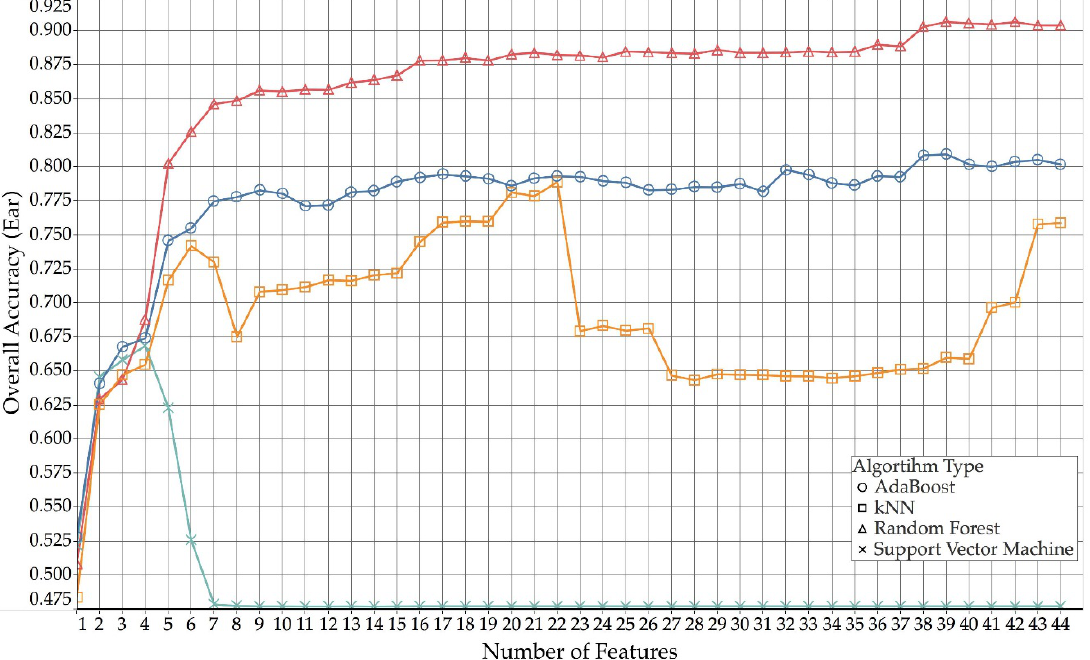
Figure 3. Comparison of overall accuracies for ear, over used number of features (AdaBoost, kNN, random forest and support vector machine).